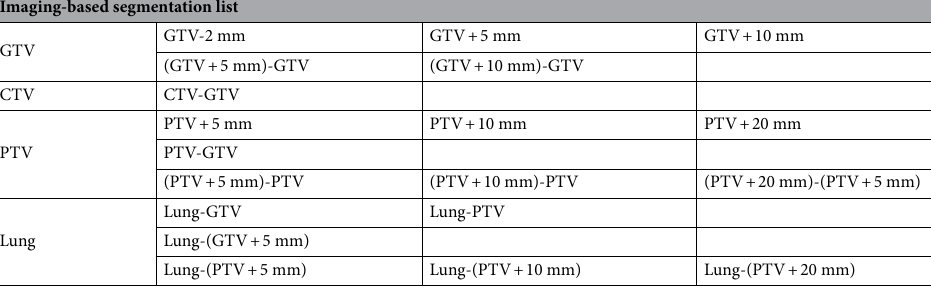
Table 1. Imaging-based segmentation list in multi-region radiomics analysis. “ROI-Xmm” indicates the inner tumor region of ROI minus X mm of the outer edge. ROI is the region of interest, which represents the GTV, CTV, PTV, or whole lung in the current study. “ROI + Xmm” indicates the expanded region from the ROI. “(ROI + Xmm)-ROI” indicates the shell region within X mm around the ROI. GTV gross tumor volume, CTV , clinical target volume, PTV planning target volume.